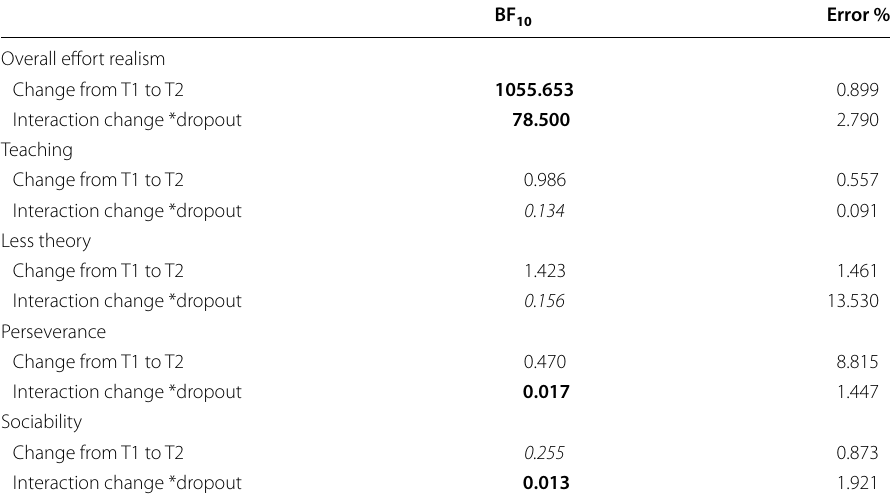
Table 7 Bayesian repeated measures ANOVA to show change of expectations after a year or when dropping